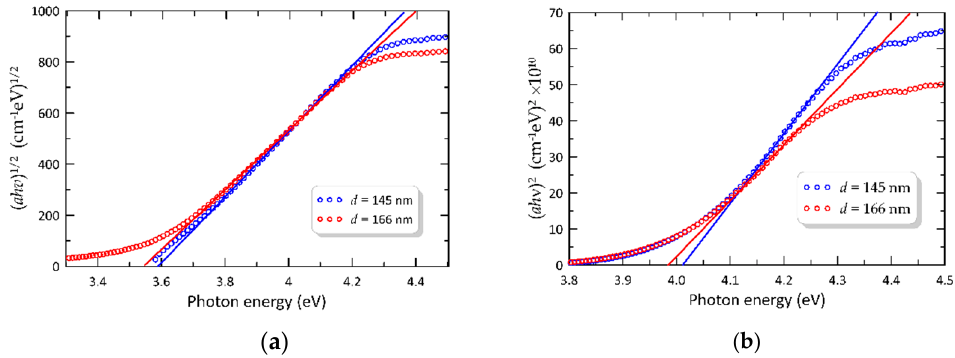
( ) α ν⋅ 1 2 ( ) α ν⋅ 2 Figure 13. Tauc plot of ( α · h ν ) 1/2 and ( α · h ν ) 2 as a function of ( h ν ) for indirect ( a ) and direct h and h as a function of ν ( ) h for indirect ( a ) and Figure 13 . Tauc plot of ( b ) optical transitions, respectively. direct ( b ) optical transitions, respectively.